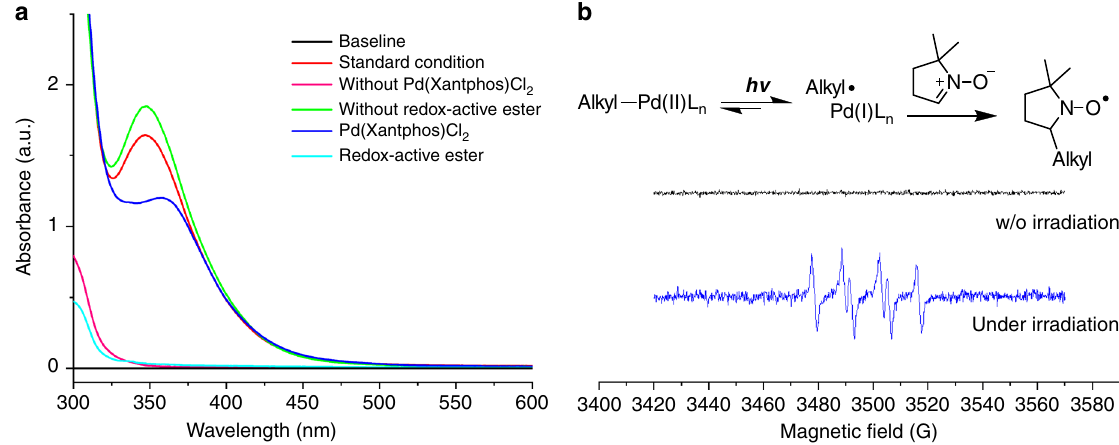
Fig. 6 Mechanism studies. a UV-Vis spectrum of reaction mixture. b Electron paramagnetic resonance (EPR) studies of reaction mixtures with and without (w/o)